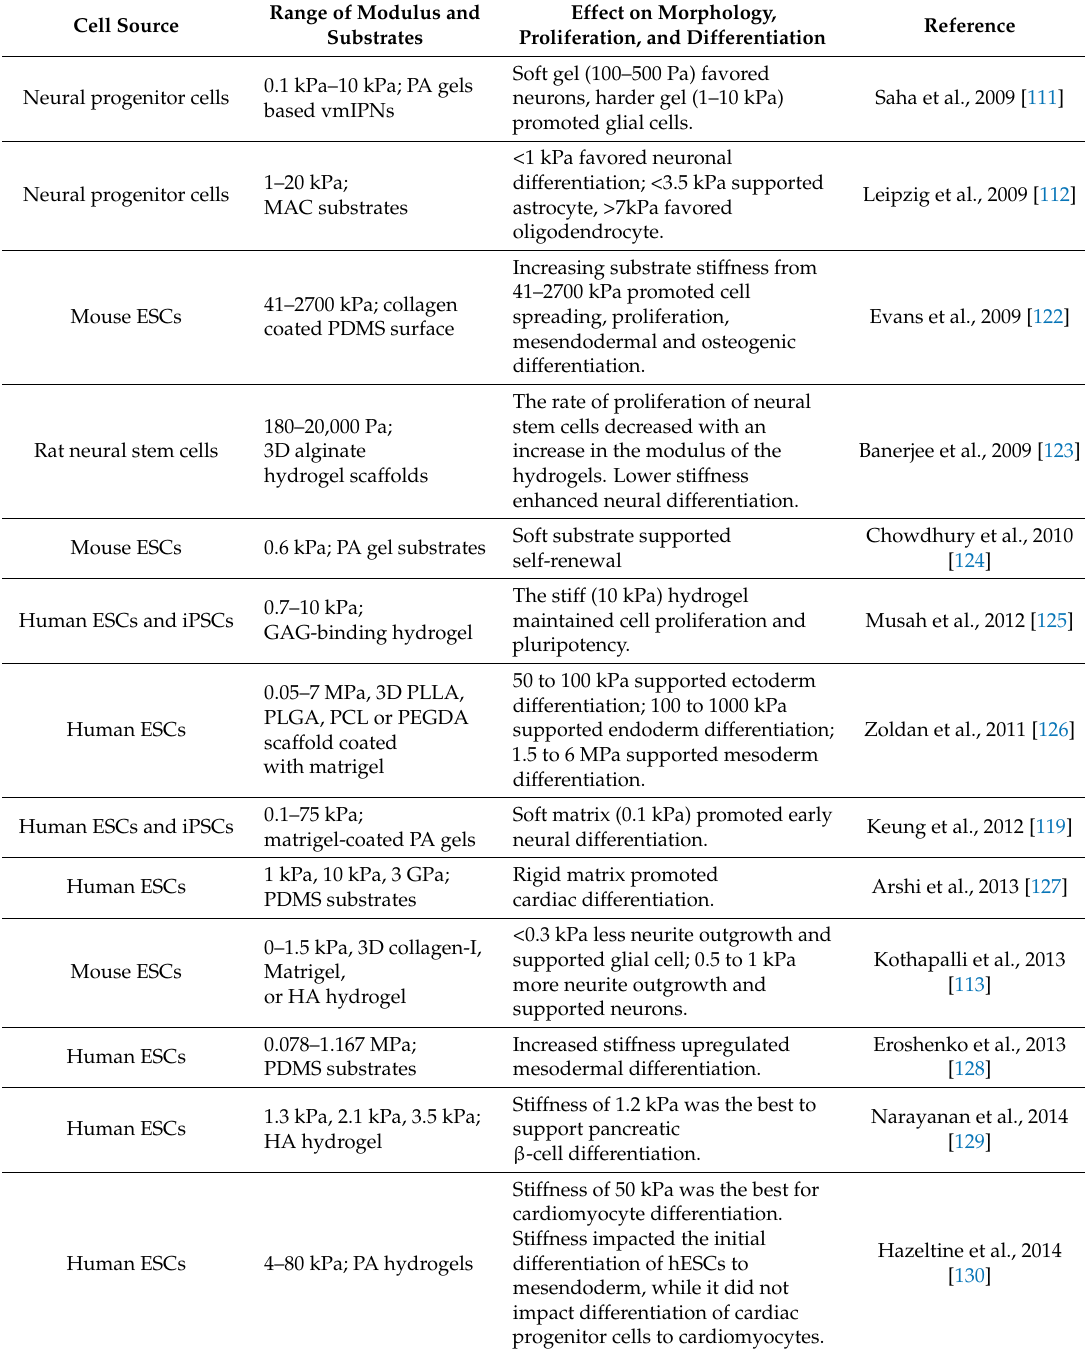
Table 2. Effects of matrix modulus on pluripotent stem cell fate